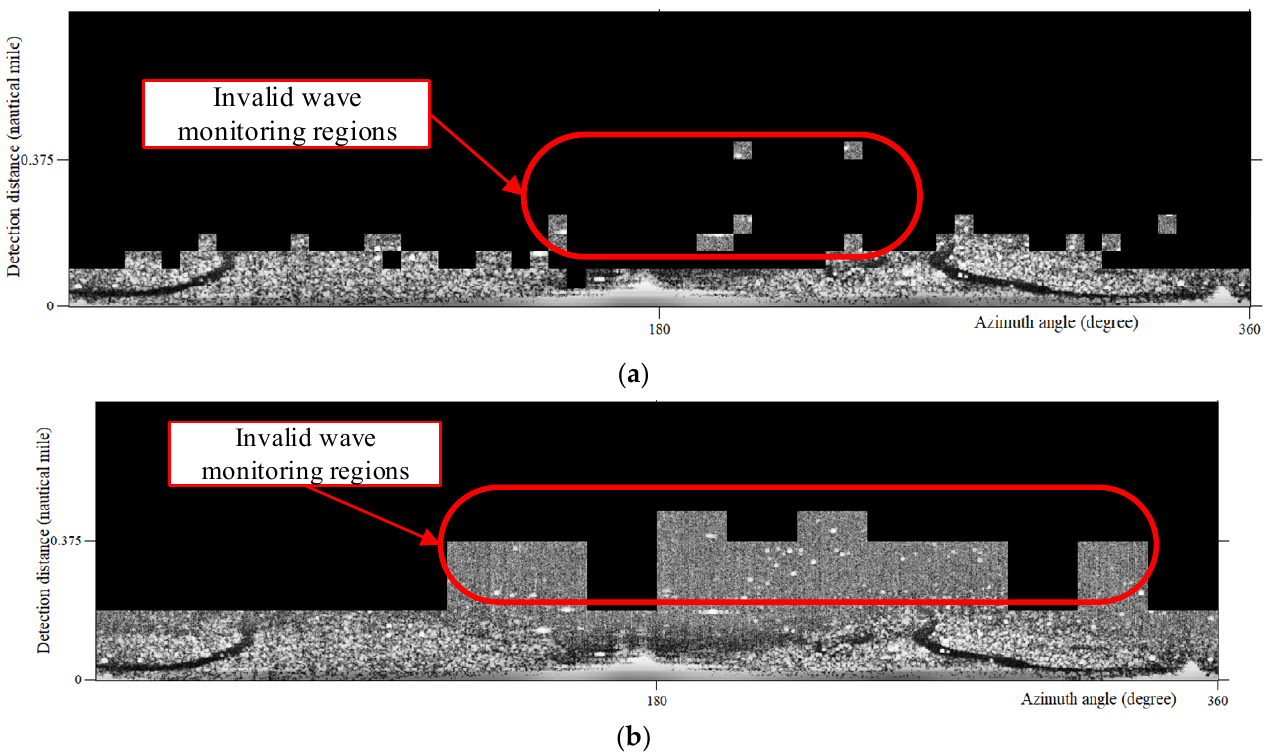
Figure 12. Effective ocean wave monitoring regions calculated by different local window sizes. ( a ) 32 × 32 pixels; ( b ) 128 × 128 pixels. Table 2. Time consumed for extracting effective monitoring regions of ocean waves with different local window sizes.